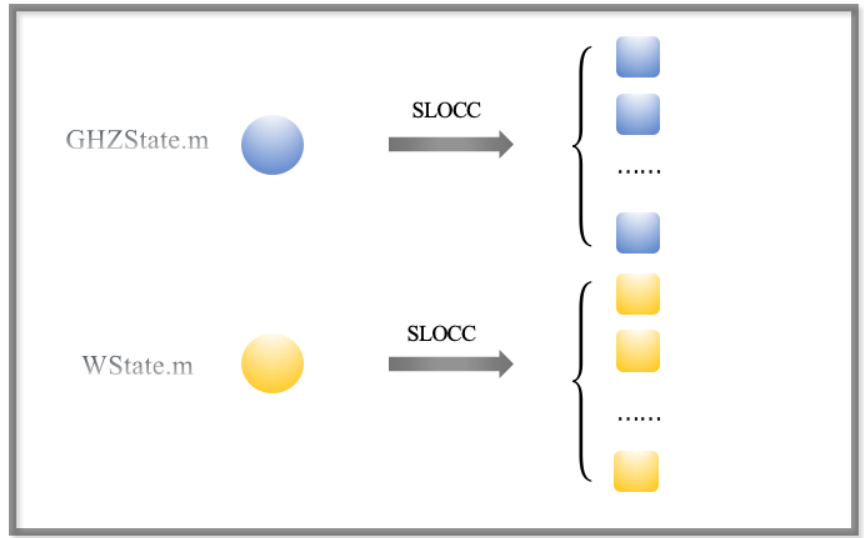
Figure 4. Schematic diagram for generating the training set. We implemented the typical forms of ⊗ n + | 1 (cid:105) ⊗ n ( | 100. . .0 (cid:105) + | 010. . .0 (cid:105) + . . . + | 000. . .1 (cid:105) ) as √ GHZ states | GHZ (cid:105) = | 0 (cid:105) and W states | W (cid:105) = 1 √ n 2 the original sates and generated SLOCC to transfer 191 these states and form more states in the GHZ states set and W states set. We adopted the result as the training